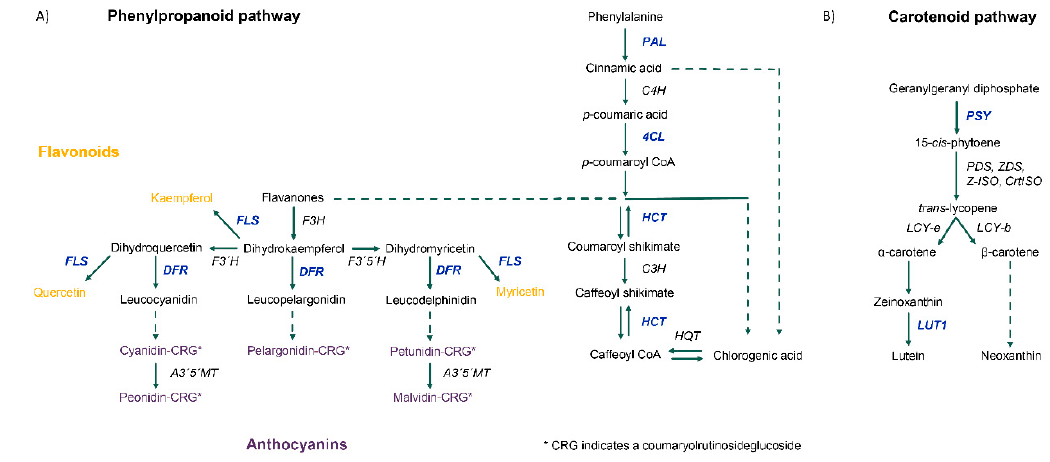
Figure 4. Diagrams depicting key enzymes in the phenylpropanoid ( A ) and carotenoid ( B ) biosynthetic pathways. Genes that are significantly down-regulated beyond cut-off values of 5% FDR and a log-fold change greater than 2 are written in blue.